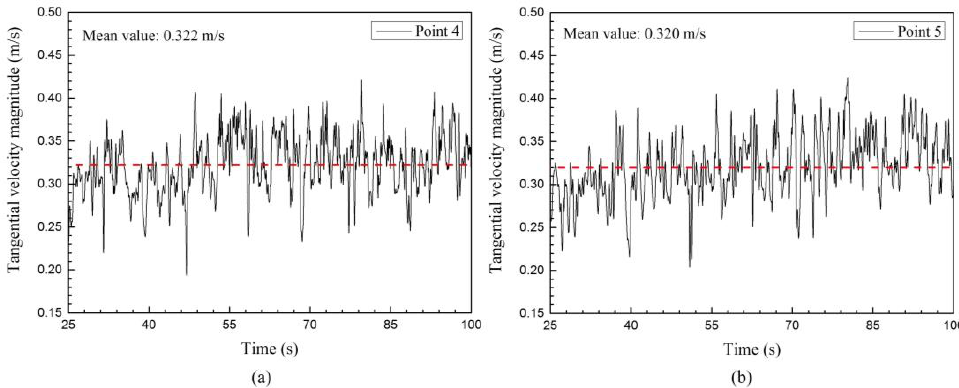
Figure 13. Time history of two symmetrical points, ( a ) Point 4 and ( b ) Point 5, at conditions of 310 A/0.5 Hz.